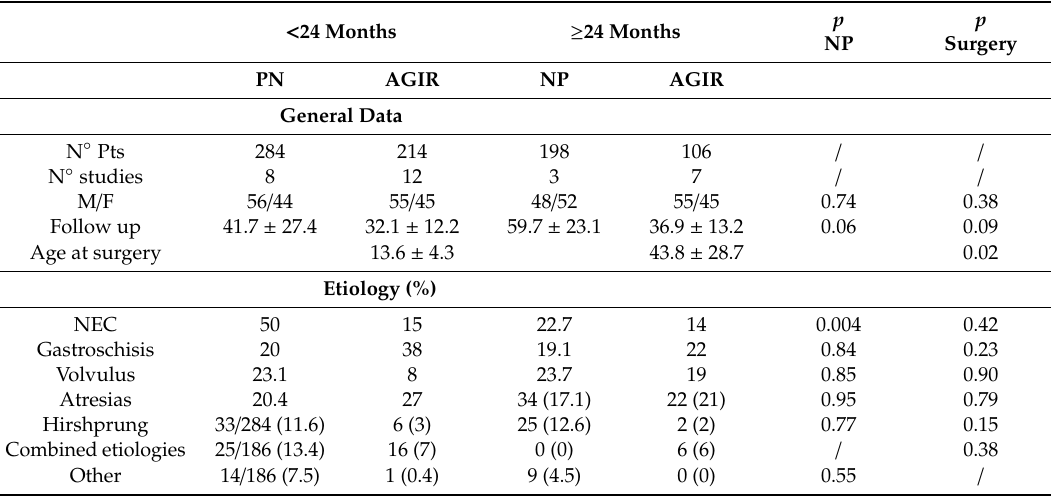
Table 5. Summary of the results according to